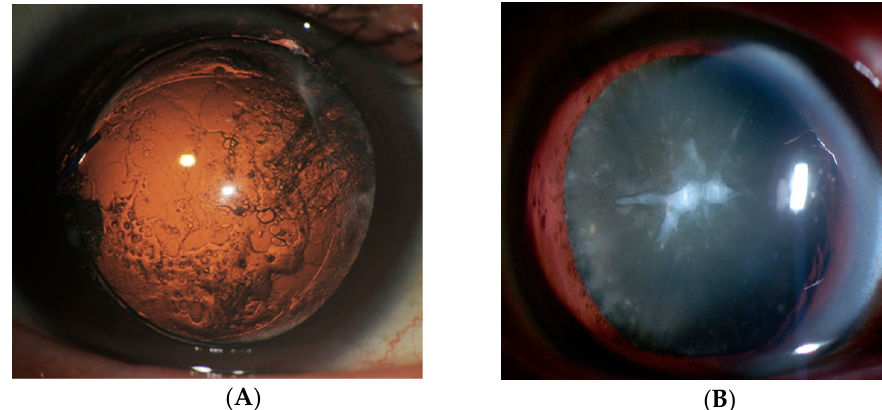
Figure 2. PCO and cataracts with Anterior subcapsular fibrosis (ASF). ( A ) Slit-lamp retroillumination photos of PCO development. PCO is the most common complication of cataract surgery. It is caused by the migration of residual LECs from the equatorial region of the lens capsule. ( B ) A slit-lamp image of a cataract with ASF. Cataracts with ASF are usually seen at the anterior pole of the lens. Fibroblastic LECs are observed in this portion.